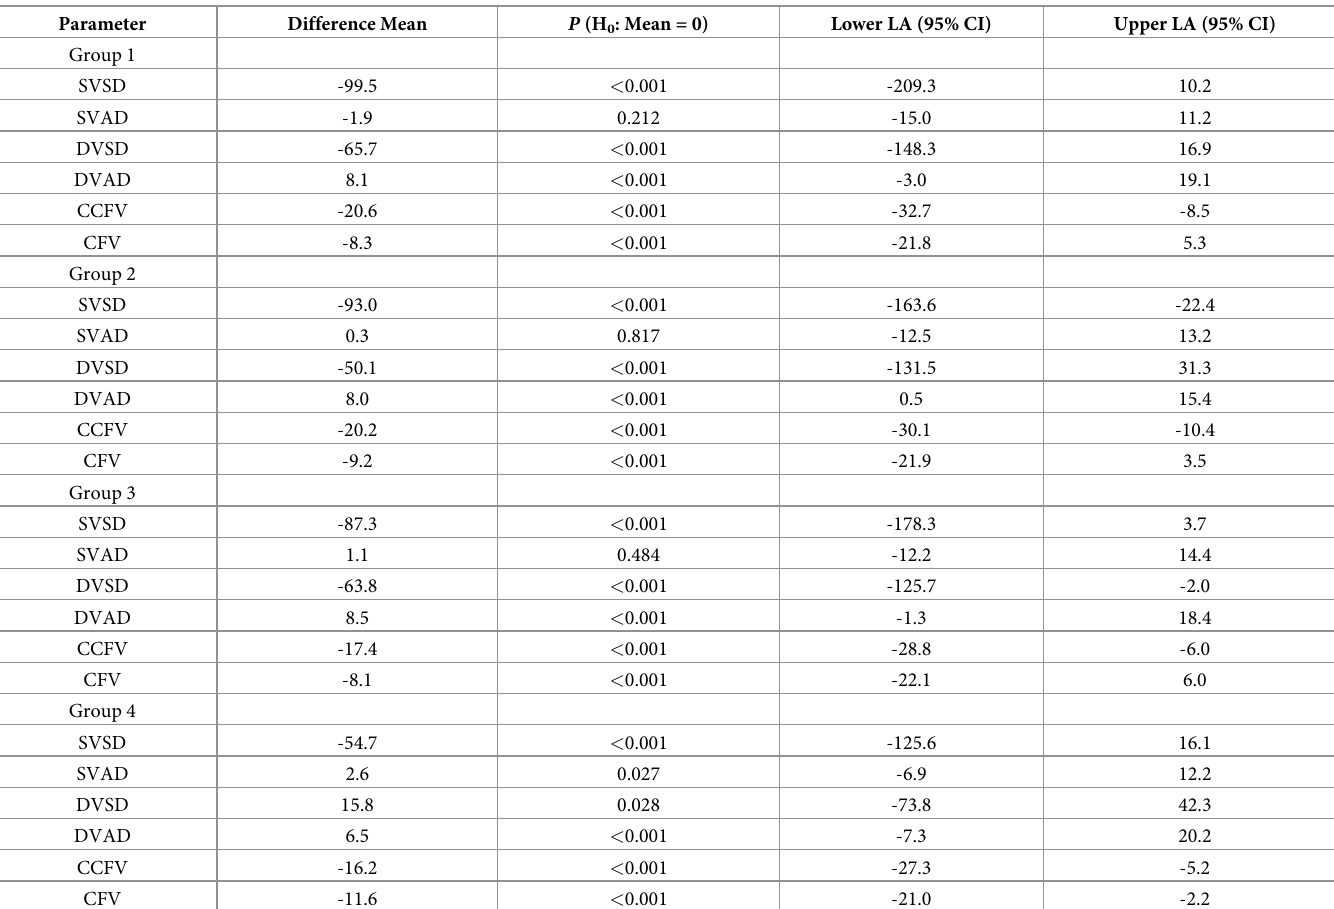
Table 2. Results of Bland-Altman analysis for VSD, VAD, CCFV and CFV for comparisons between methods A (Zeiss) and B